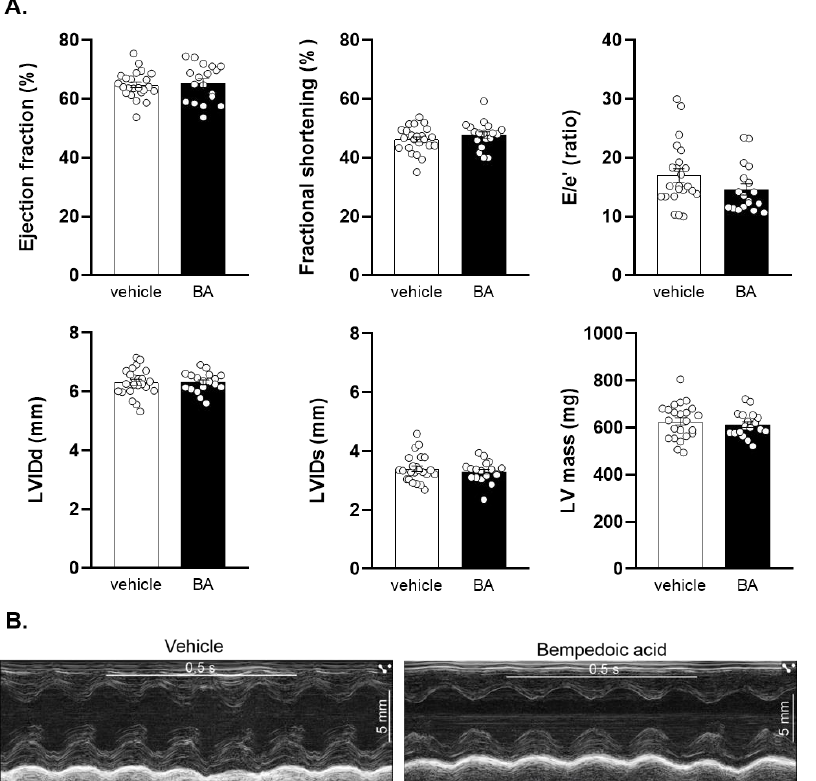
Figure 2. Baseline cardiac function after vehicle or BA treatment. ( A ) Selected parameters of systolic and diastolic function are shown. Chronic treatment with bempedoic acid did not affect functional or morphological parameters measured by echocardiography. Results are presented as means ± SEM. Statistics: Student’s two -tailed t -test or Mann – Whitney U-test: n.s., n = 18 for BA and n = 23 for vehicle treated groups. ( B ) Representative echocardiographic M-mode images of vehicle and BA treated animals. Scale bar: 5 mm. Time stamp: 0.5 s. BA: bempedoic acid. EF: ejection fraction. FS: fractional shortening. E/e’ : ratio between peak Doppler blood inflow velocity across the mitral valve during early diastole and peak tissue Doppler of myocardial relaxation velocity at the mitral valve annulus during early diastole. LVIDd: left ventricular internal diameter at diastole. LVIDs: left ven-